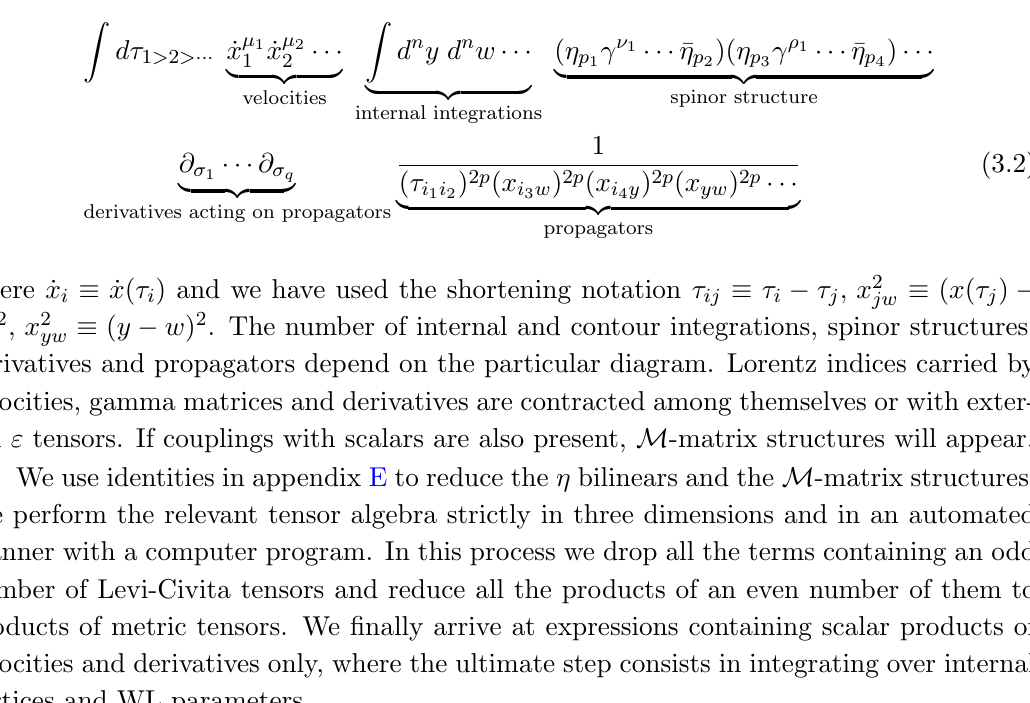
Figure 3 . An example of a diagram identically vanishing in the ’ = 0